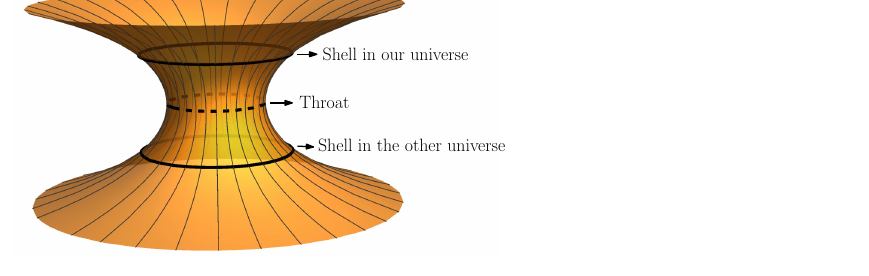
Figure 5. Immersion diagram of the deformed Schwarzschild-like wormhole, with the thin material shells nearby the throat at its two opposite